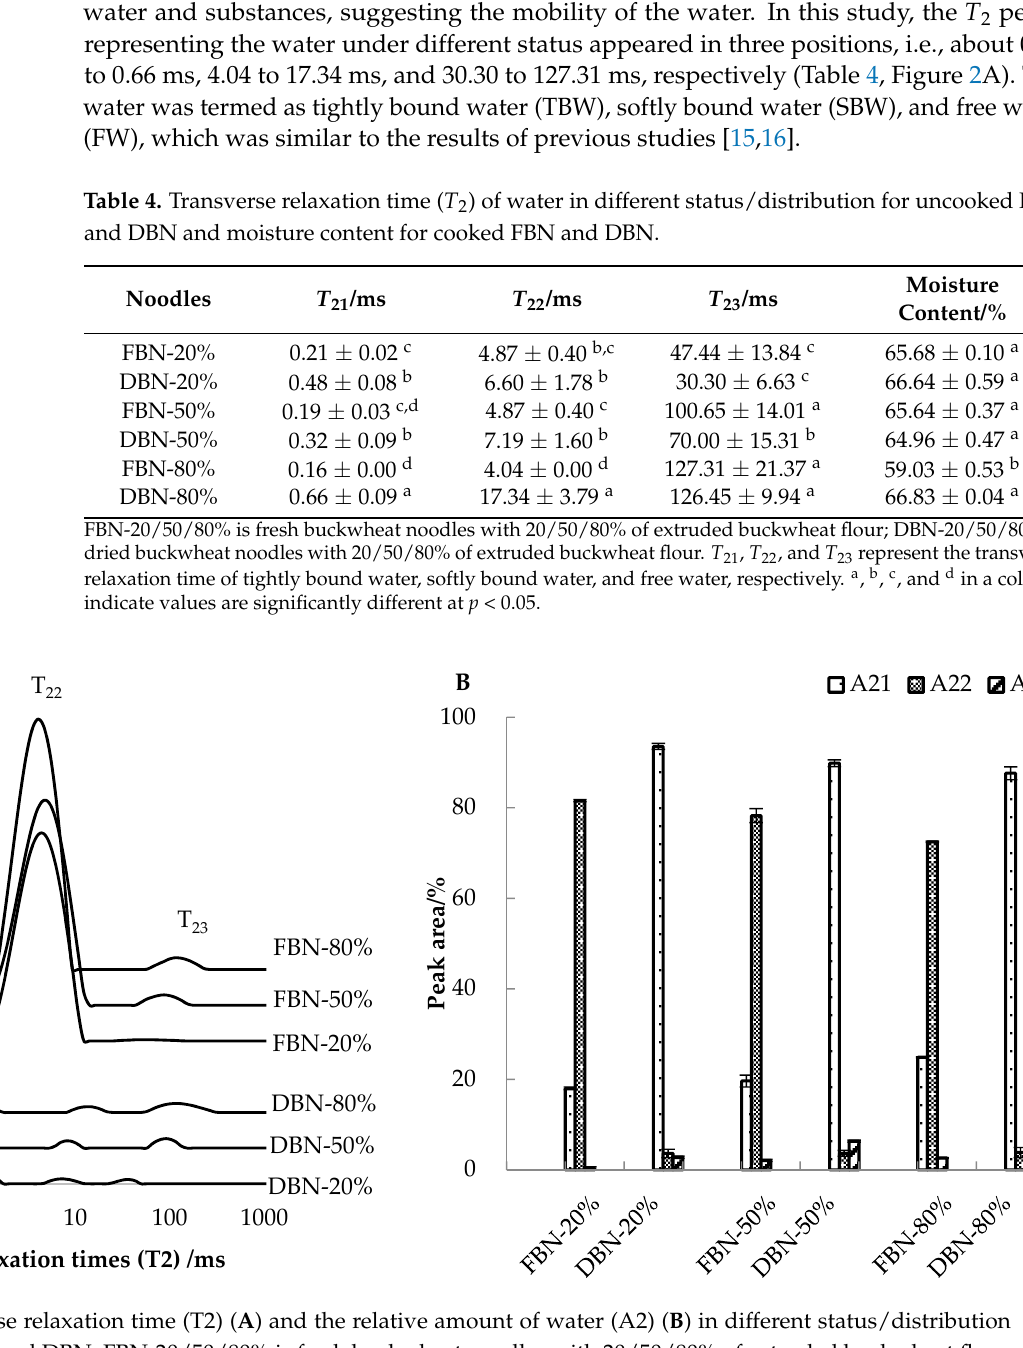
Figure 2. Transverse relaxation time (T2) ( A ) and the relative amount of water (A2) ( B ) in different status/distribution for uncooked FBN and DBN. FBN-20/50/80% is fresh buckwheat noodles with 20/50/80% of extruded buckwheat flour; DBN-20/50/80% is dried buckwheat noodles with 20/50/80% of extruded buckwheat flour. T 21 , T 22 , and T 23 represent the transverse relaxation time of tightly bound water, softly bound water, and free water, respectively. A 21 , A 22 , and A 23 are the proportion of tightly bound water (TBW), softly bound water (SBW), and free water (FW),